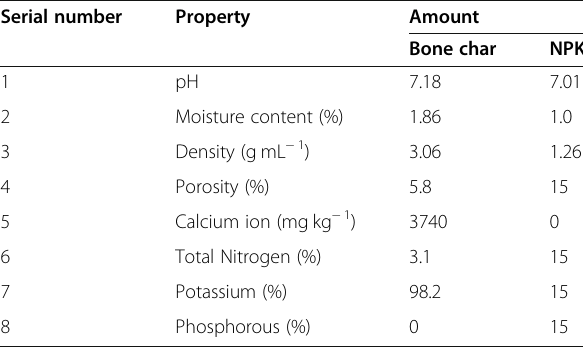
Table 3 Physicochemical properties of bone char and NPK fertilizers